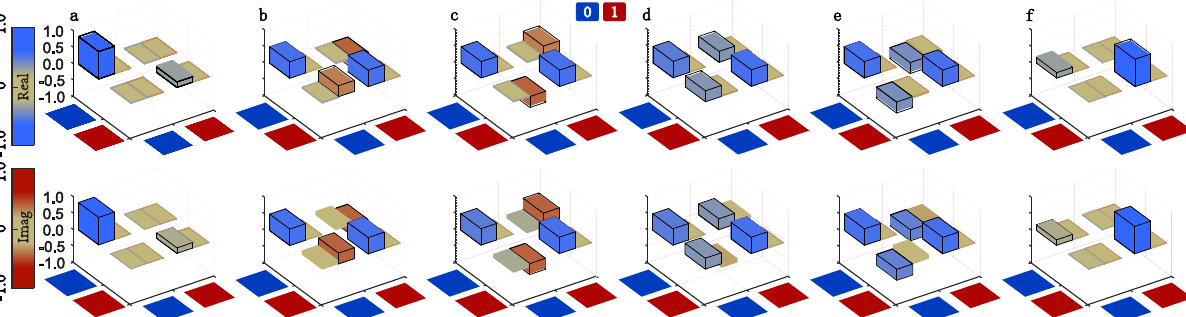
ffiffiffi ffiffiffi ffiffiffi p p p 2 2 2 ; c 0 1 j i (cid:2) i 1 1 j ið Þ = ; d 0 1 j i þ 1 1 j ið Þ = ;